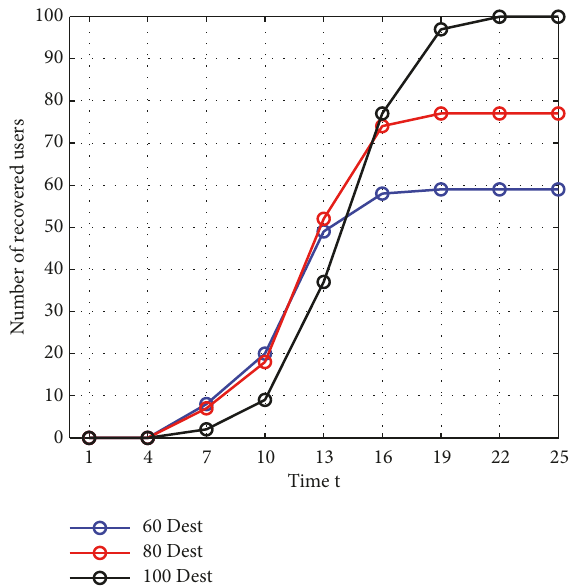
Figure 8: Theevolution of recoveredusersovertime underdifferent destinations.